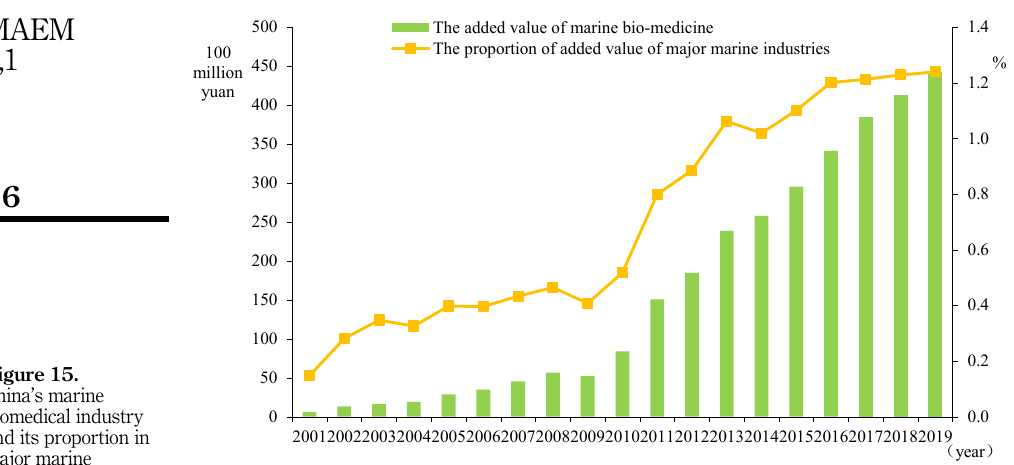
Figure 15. China ’ s marine